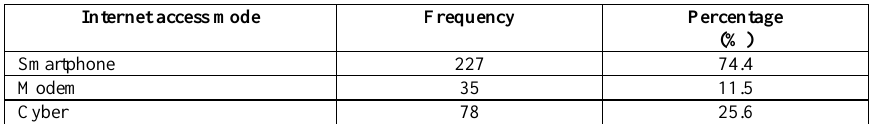
Table 7. Teachers Mode of Internet Access